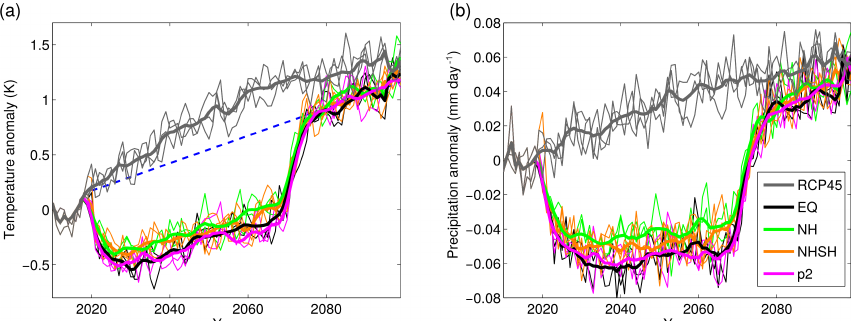
Figure 7. Global mean (a) temperature, (b) precipitation anomaly compared to the mean temperature for 2010–2020. The thick solid line shows the 5-year running ensemble mean values and each narrow line indicates the yearly mean values of one ensemble member. The blue dashed line shows the temperature after year 2020 according to the mean warming rate in EQ between years 2030 and